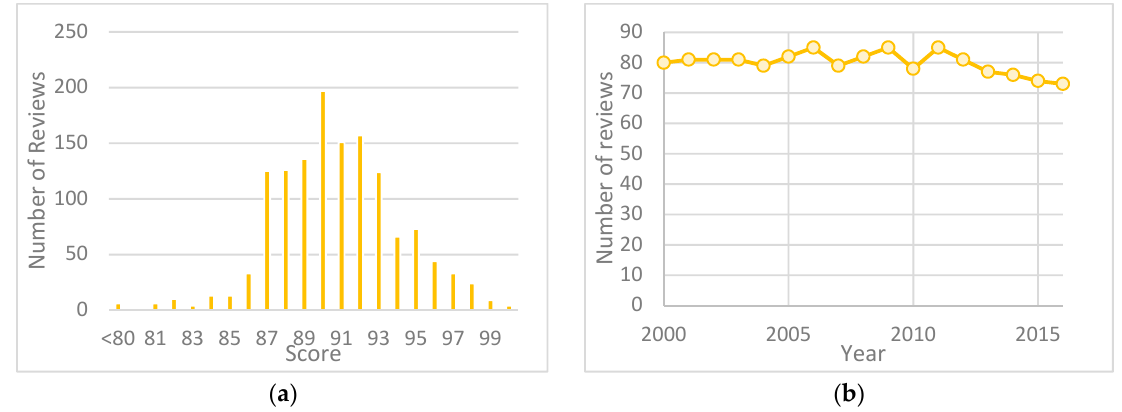
Figure 3. (a) The score distribution of Bordeaux Wine Official Classification in 1855; ( b ) The number Figure 3. ( a ) The score distribution of Bordeaux Wine O ffi cial Classification in 1855; ( b ) The number of of wines reviewed annually. wines reviewed